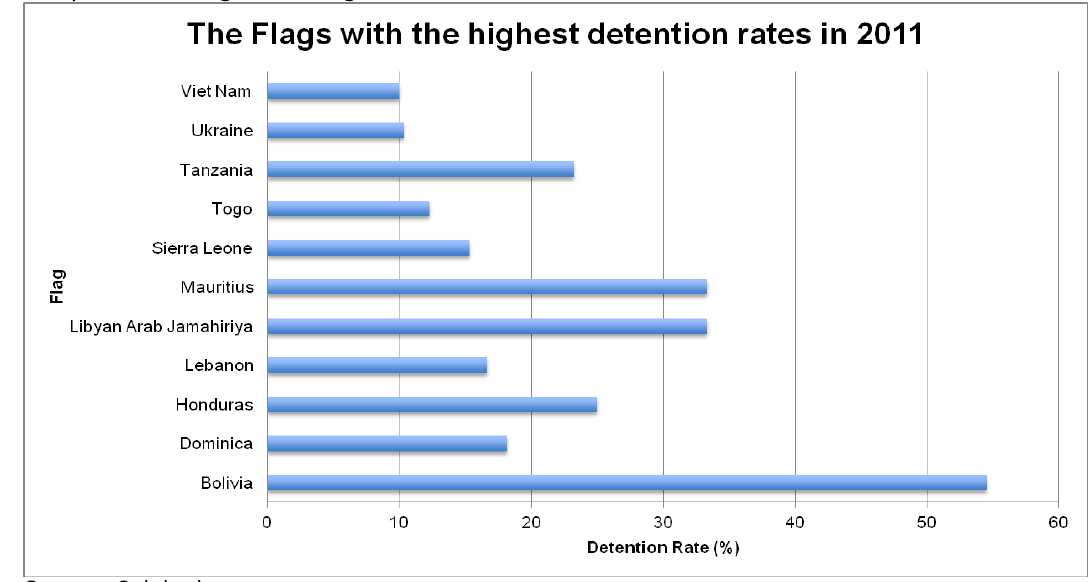
Graph 9B : Flags with highest detention rates 2011